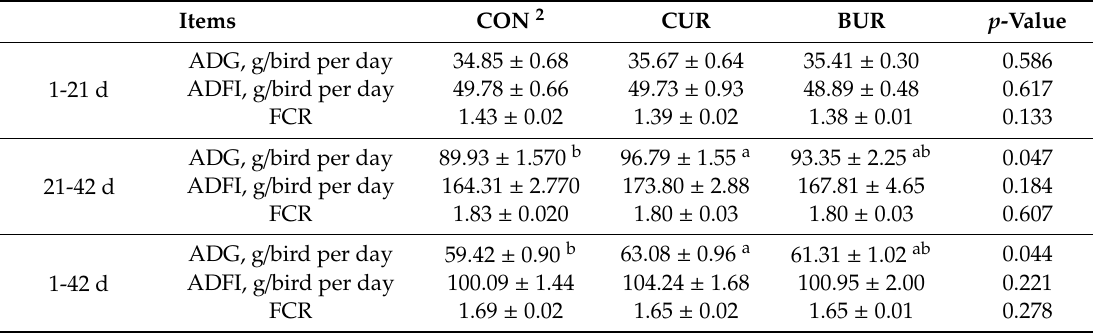
Table 3. E ff ects of curcumin and bisdemethoxycurcumin on the growth performance in broilers (Experiment 2) 1